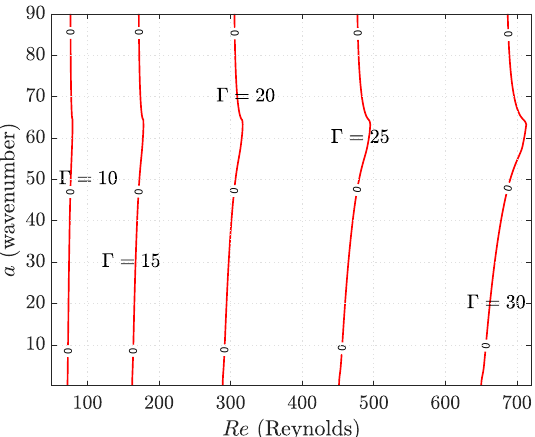
Figure 9. Neutral stability curves in the ( α , Re ) plane, channel flow. Γ = 10,15,20,25,30.